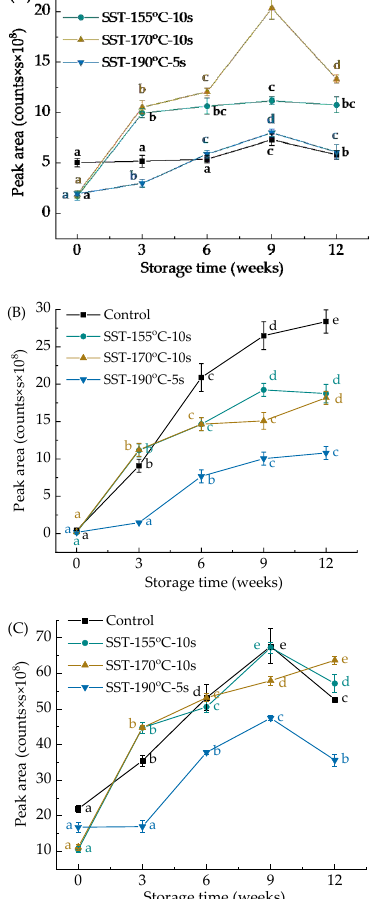
Figure 4. Effect of superheated steam treatment on peak area of volatile compounds in dried whole wheat noodles during storage. ( A ) The peak area of Hexanal, ( B ) the peak area of 2-pentylfuran, ( C ) total volatile compounds. The lowercase letters in the column chart indicate the significant difference of the same sample in different storage time at p < 0.05. SST: superheated steam treatment.